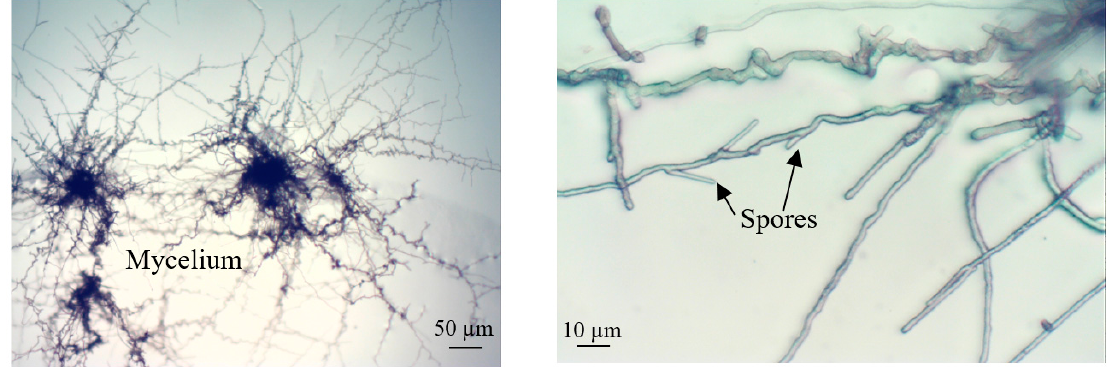
Figure 9. Microscope images of C. macrocarpum cultured in the all-glass LOC. Culturing conditions—ambient temperature, no lightning.